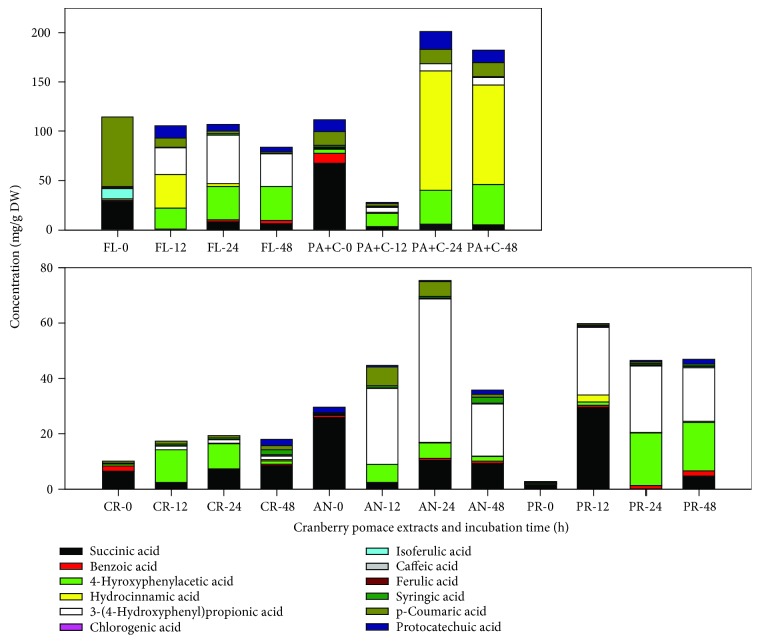
Changes in concentration of different phenolic acids as a result of bioconversion of cranberry proanthocyanidins using L. rhamnosus during the incubation. Data presented the mean values of n = 3 with respect to the medium control. CR: crude; AN: anthocyanin; PR: proanthocyanidin: FL: flavonol; PA+C: phenolic acid+catechin. 0, 12, 24, and 48 are the incubation time (hours).